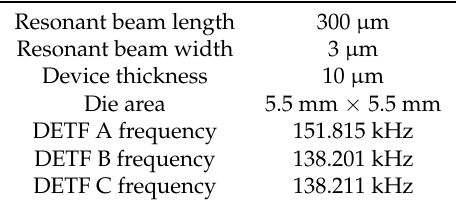
Figure 3. Vibration mode of DETF B ( a ), and its resonant frequency versus inclination ( b ). Table 1. The geometry dimensions of DETF